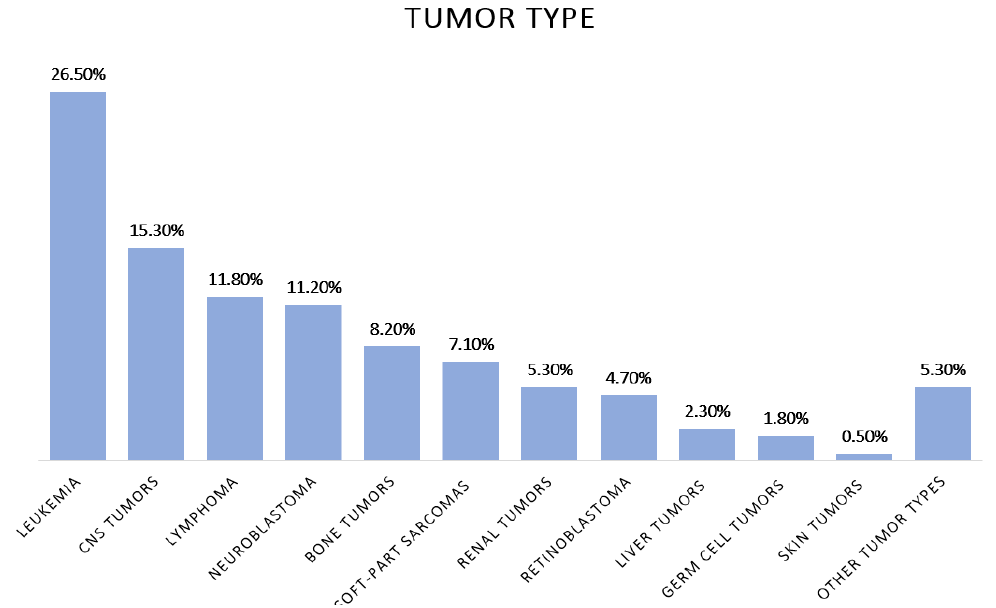
Figure 2. Distribution of patients (%) by tumor type.